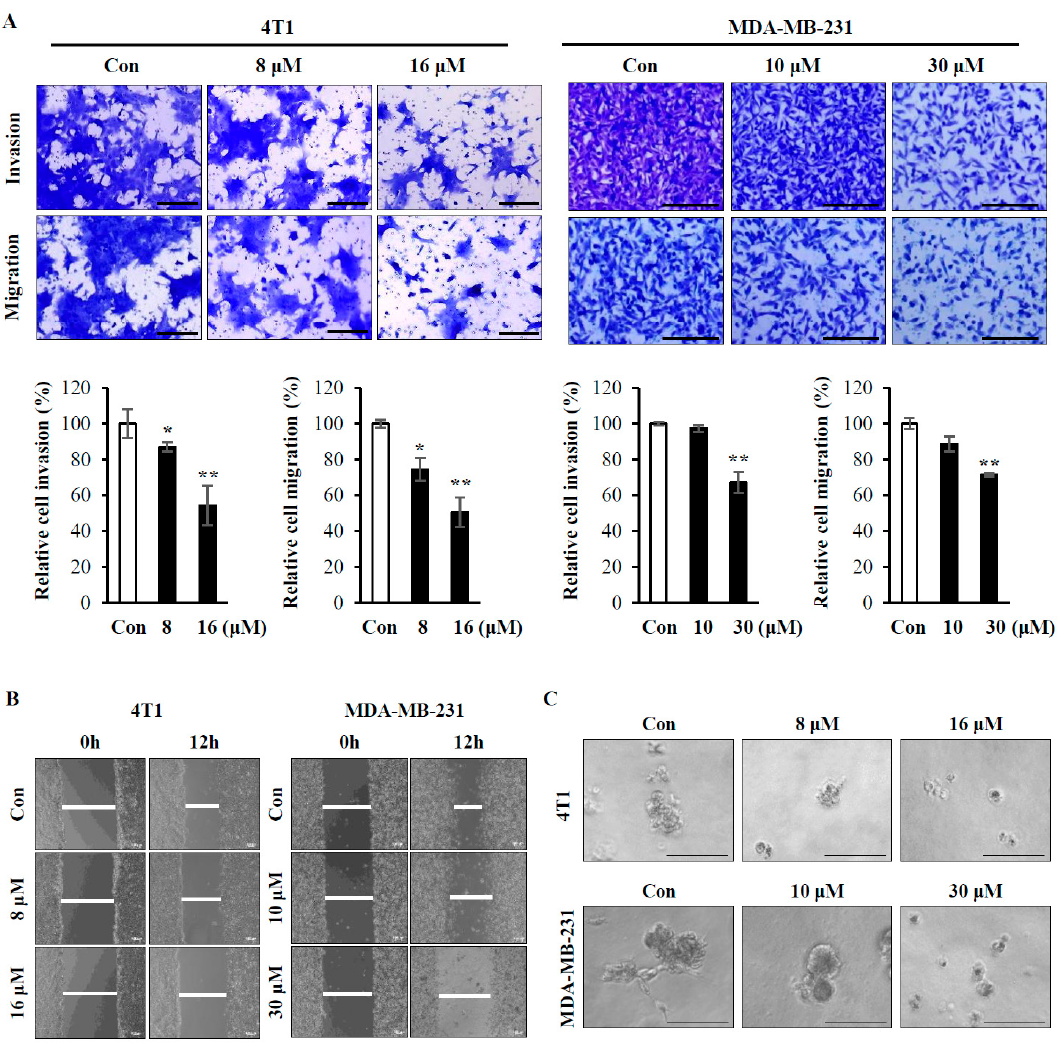
Figure 6. Effects of PA on invasion, migration, wound healing, and growth in 3D culture conditions ( A , B ) 4T1 cells and MDA-MB-231 cells (4 × 10 4 cells/well) were plated into the Transwell upper chamber with the indicated concentrations of PA, followed by incubation for 20 h. Invaded and migrated cells were then stained with 0.5% crystal violet. For invasion assays, the upper chambers were precoated with matrigel. Representative images were taken and scanned to quantify three different areas ( A ). Scale bars = 50 µm. ( B ) Confluent cells were grown in a 12 well plate, and cell monolayers were scratched with a pipet tip. Cells were then incubated with or without PA for 12 h, followed by image capture. Magnification = 50×, Scale bar = 100 µm. ( C ) 2 × 10 3 cells in 300 µL of 5% matrigel were plated in the matrigel-coated 8-well chamber with the indicated concentration of PA, as described in Section 4. Colony images were captured after 6 days of incubation. Scale bar = 100 µm. Similar results were observed in three independent experiments. Error bars represent standard deviations of the mean of three measurements (* p < 0.05, ** p < 0.01).